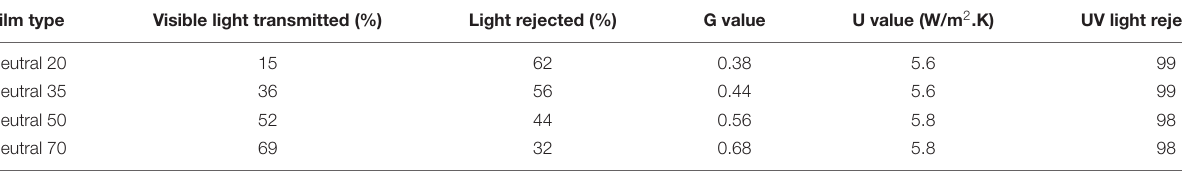
TABLE 2 | Window film products of the 3M company.